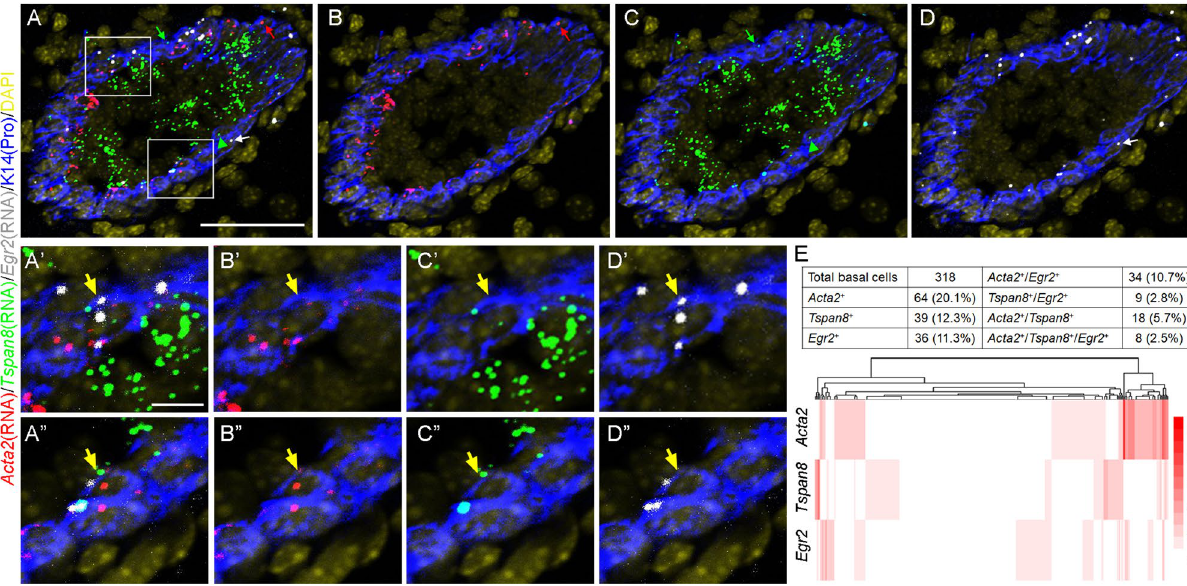
Figure 3. RNAScope validation of differential expression of several basal transcriptional state markers. ( A – D ) Representative 5-channel ( A ) and 3-channel ( B – D ) images showing the expression of Acta2 (red), Tspan8 (green), Egr2 (white) in the mammary gland of 10-week-old virgin females. K14 protein immunostaining (blue in all images) marks the basal cells. DAPI stains the nuclei (artificially colored yellow in all images). Red, green, and white arrows indicate a basal cell with only Acta2 , Tspan8, and Egr2 expression, respectively. Green arrowhead indicates a Tspan8- expressing K14-positive cell that resides in basal-luminal border. Boxed areas in ( A ) are enlarged in ( A ʹ – D ʹ ) and ( A ʺ – D ʺ ) to highlight basal cells with more than one marker detected (indicated by yellow arrow). Scale bar = 50 μm in ( A – D ); 10 μm in ( A ʹ – D ʹ ) and ( A ʺ – D ʺ ). ( E ) Quantification results